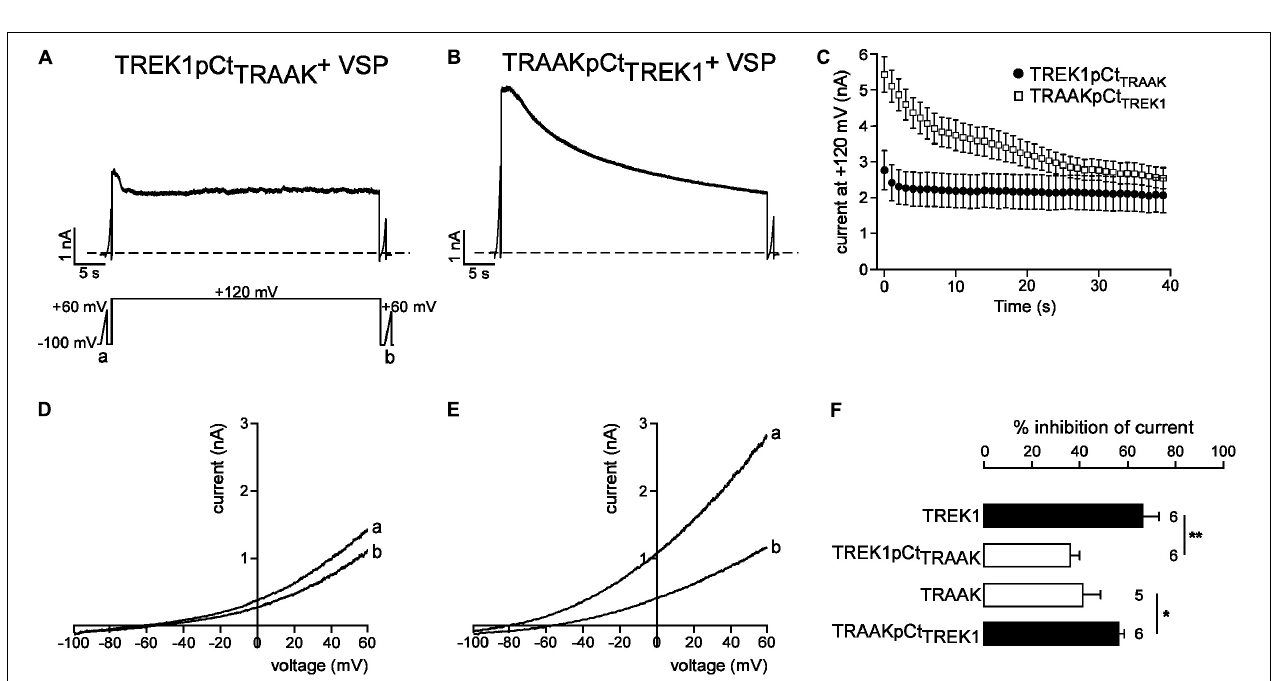
FIGURE 7 | Role of pCt in TREK1 and TRAAK differential sensitivities to PIP 2 . (A,B) Representative perforated patch-clamp recordings from HEK cells co-expressing VSP and TREK1pCt TRAAK (A) and TRAAK pCt TREK1 (B) . (C) Average currents measured at +120 mV during VSP-induced PIP 2 depletion. (D,E) TREK1pCt TRAAK (D) and TRAAKpCt TREK1 (E) currents before (a) and after (b) the +120 mV/40 s depolarizing pulse. (F) Current inhibition (%) of wild-type and mutated channels at 0 mV. Data are presented as mean ± SEM. ∗ p < 0.05, ∗∗ p < 0.01, the number of cells is indicated (Student’s t -test).